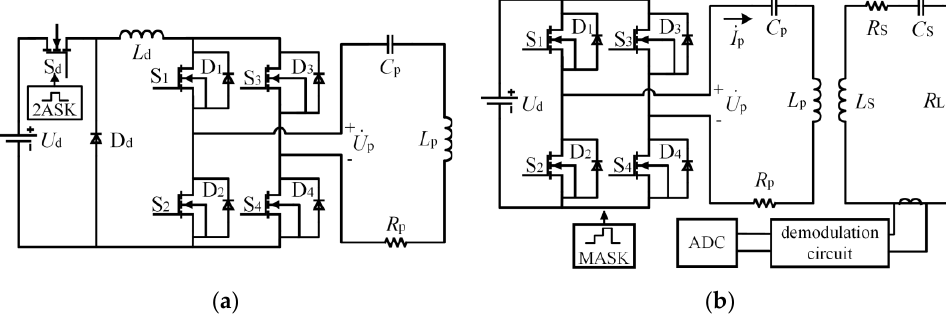
Figure 1. System structure diagram: ( a ) Traditional amplitude modulation transmission circuit; ( b ) structure diagram of MASK modulation power and information synchronous transmission system based on PSFB.